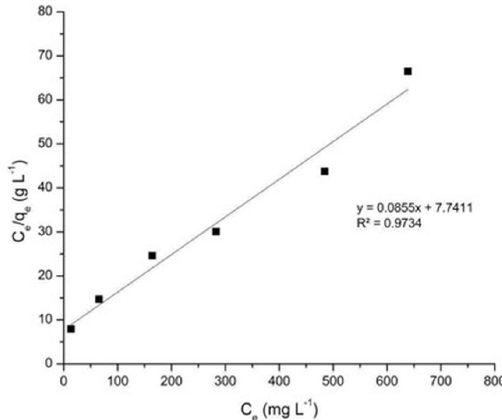
Figure 3. Linearized Langmuir adsorption isotherm model.